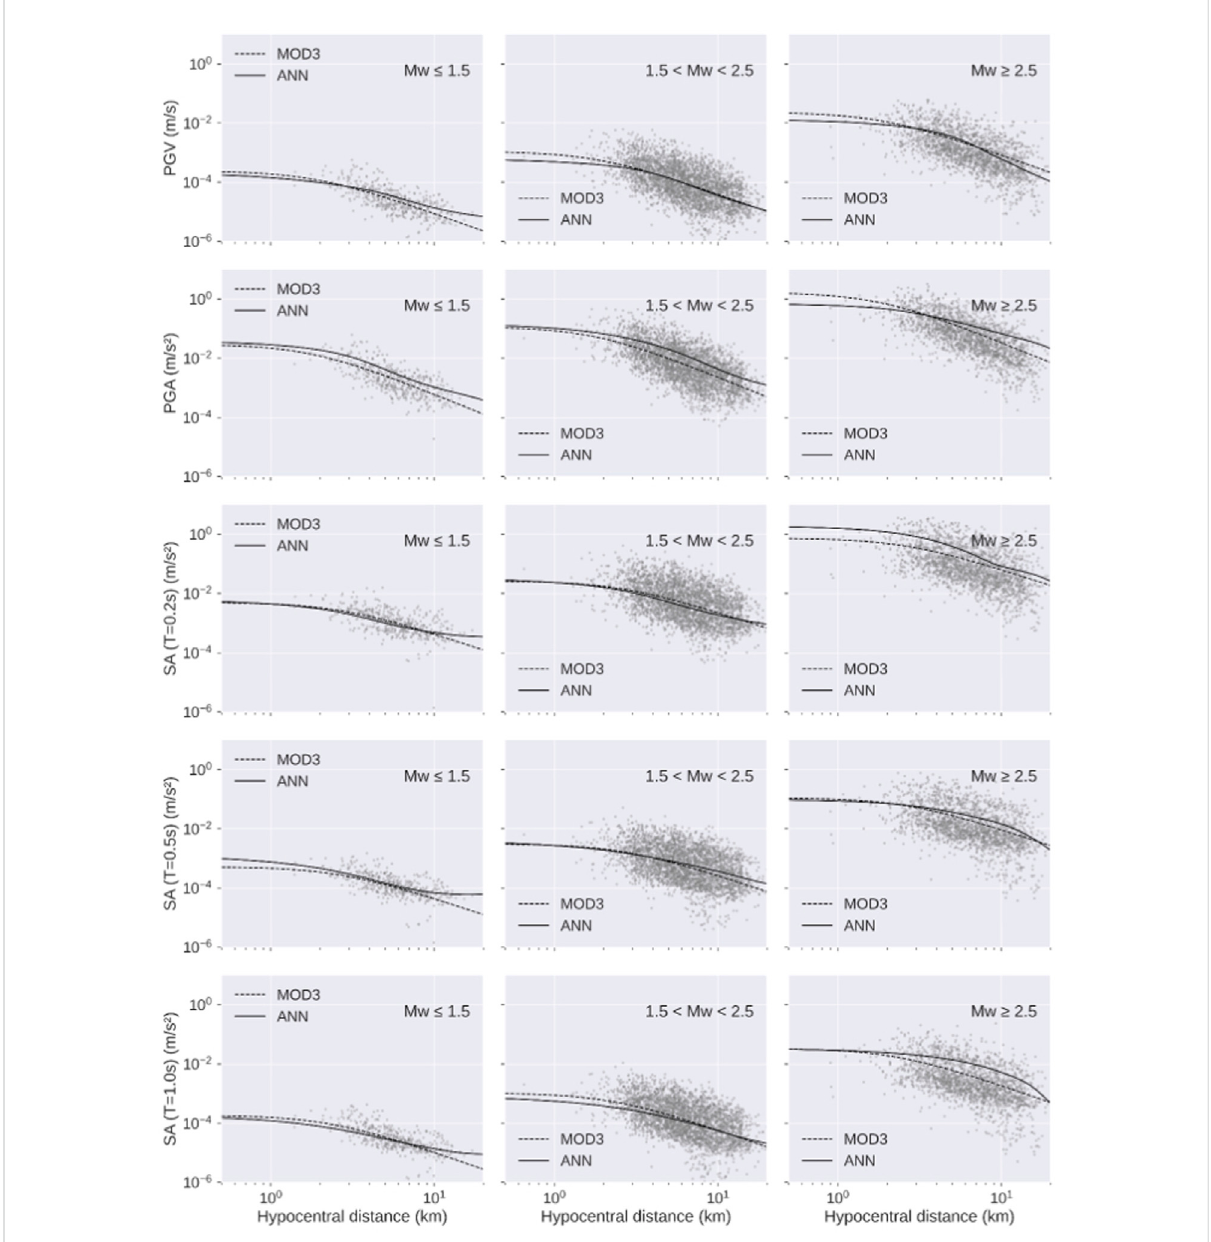
FIGURE 5 Empirical GMM (dashed line) and the DL model (continuous) plotted as function of the hypocentral distance for three classes of magnitude whose central value is reported in each panel. The dots represent the strong-motion observations. Peak ground motion parameters and response spectrum ordinates are colored according to the data